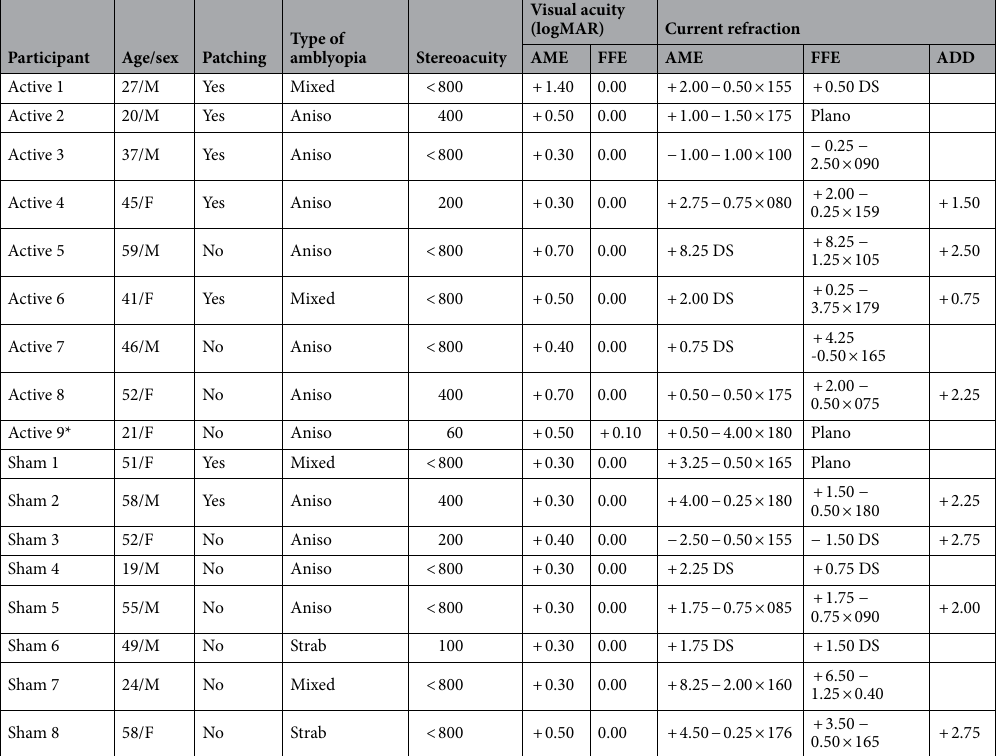
Table 1. Participant details. M = male, F = female, patching = previous history of occlusion therapy, mixed = mixed amblyopia, aniso = anisometropic amblyopia, strab = strabismic amblyopia, stereoacuity is presented in seconds of arc, AME = amblyopic eye, FFE = fellow fixating eye, add = near power addition. *Indicates the participant with missing data for the amblyopic eye contrast sensitivity measurement